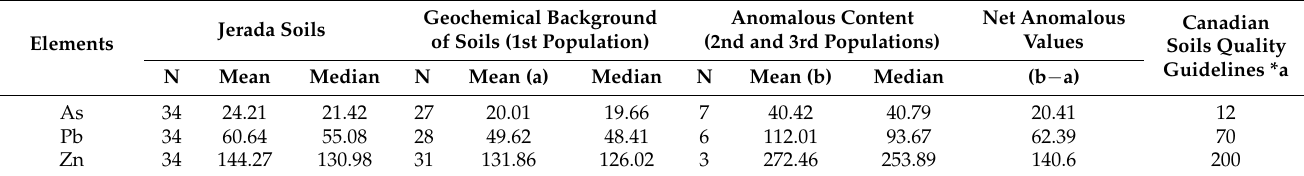
Table 4. Geochemical background values, anomalous values, and net anomalous values obtained for the Jerada